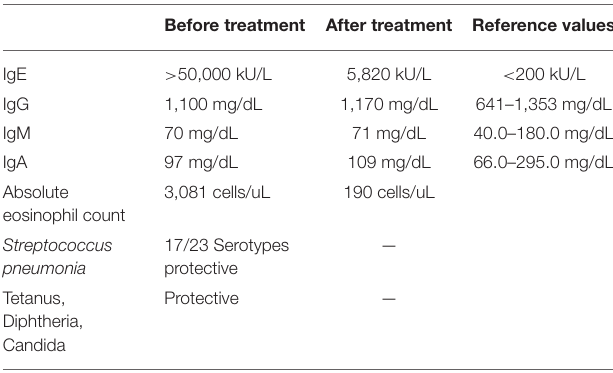
TABLE 1 | Humoral immunity panel: patient had elevated IgE levels but normal IgG/M/A and normal responses to protein and polysaccharide-based vaccines. Before treatment After treatment Reference